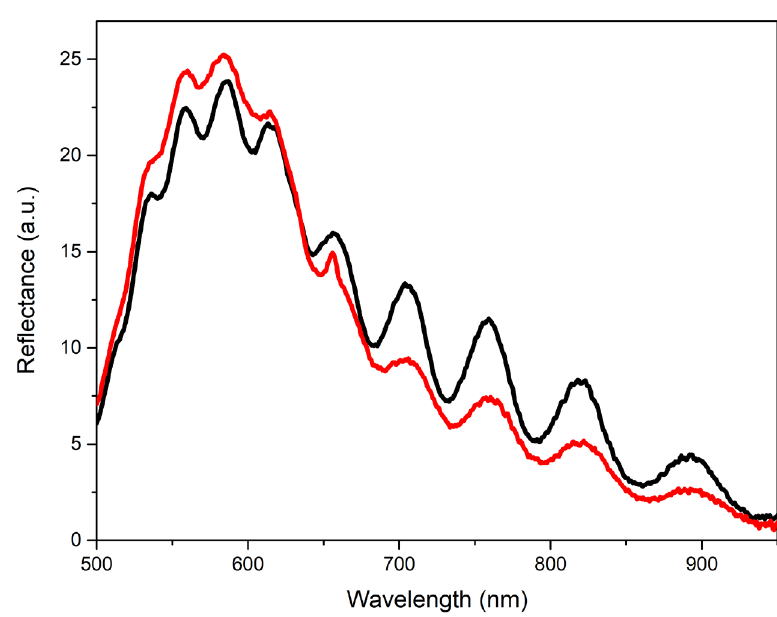
Figure 9. Reflectance spectra of a type-R-II film before (black) and after (red) covering it with a protecting Al 2 O 3 nanolayer recorded under illumination with an LED source under the angle of ~60°.